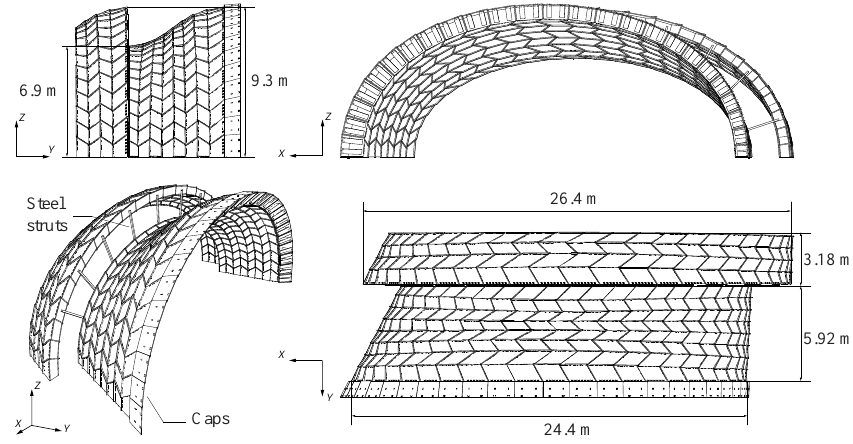
Figure 2. Geometry of the tested prototypes of arch n° 22 and half of n°